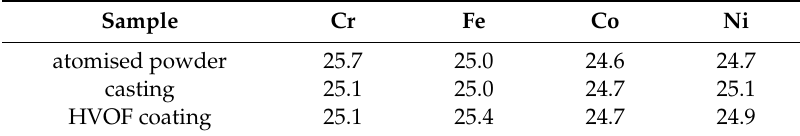
Table 4. Chemical composition of atomised powder, casting, and HVOF coating in at.%, measured by energy-dispersive X-ray spectroscopy (EDS).